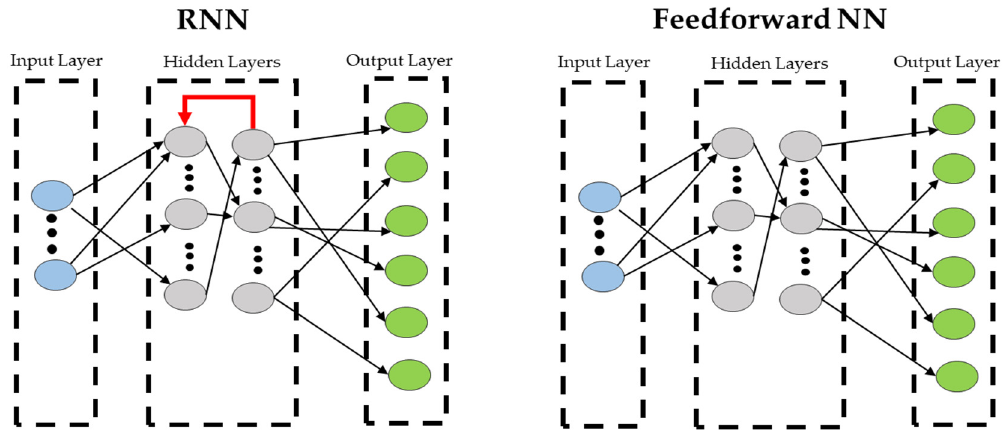
Figure 2. Examples of the network architectures of RNN and feedforward NN.